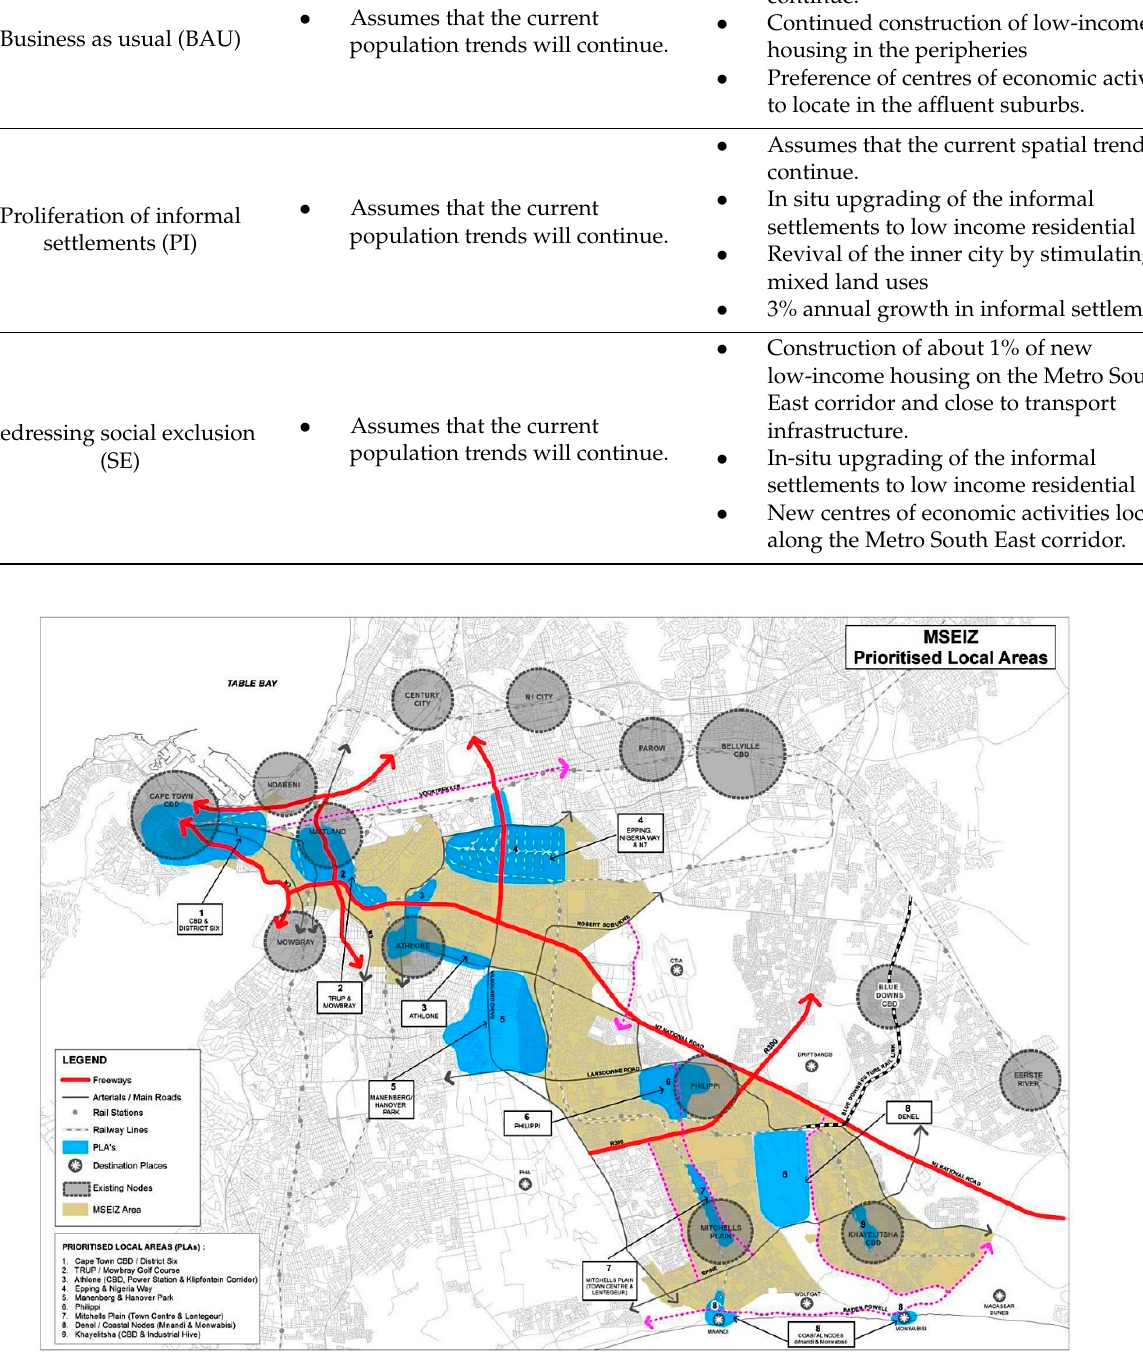
Figure 4. Metro South East Integration Zone in Cape Town (Source City of Cape Town) . To simulate different land use development scenarios, a set of assumptions were made for each of the urban development scenarios. These are presented in Table 6.